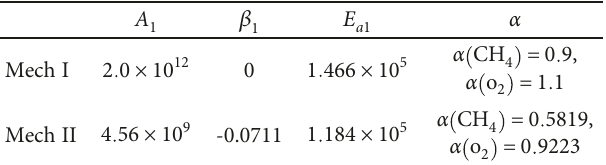
Table 1: Arrhenius parameters for the fi rst reaction (units: kmol, m, s, kJ, and K).